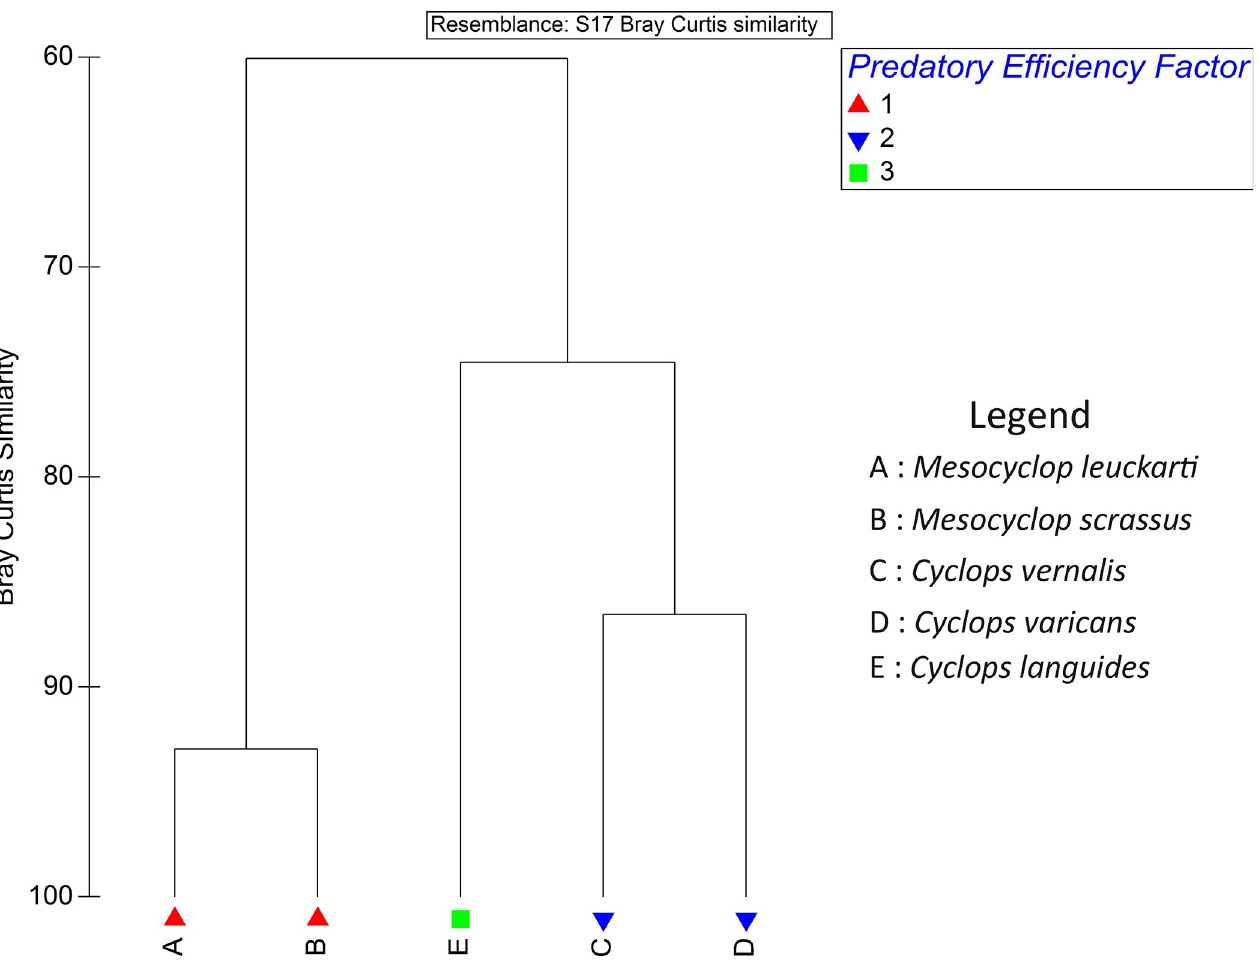
Fig 4. Dendrogram of the cluster analysis for the copepods based on predatory efficiency on Aedes larvae.